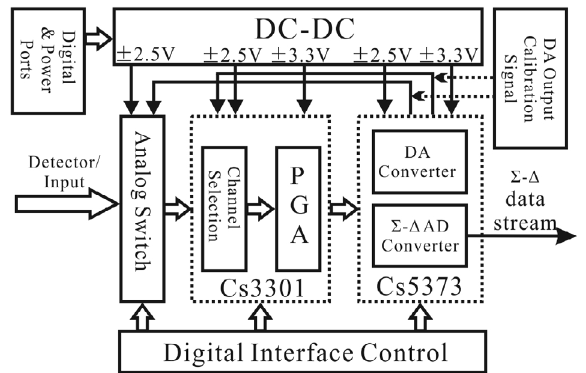
Figure 3 . Block diagram of the analog board of the data-acquisi- tion station.